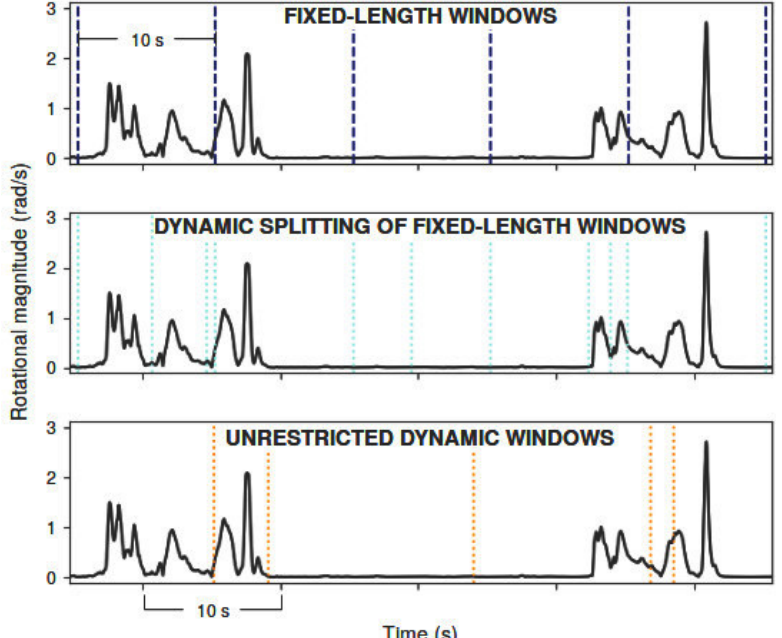
Figure 1. Segmentation results of a drinking activity (2 sips) following different windowing approaches. Vertical lines divide segmented windows. Unrestricted dynamic windows correspond to the direct implementation of the algorithm of